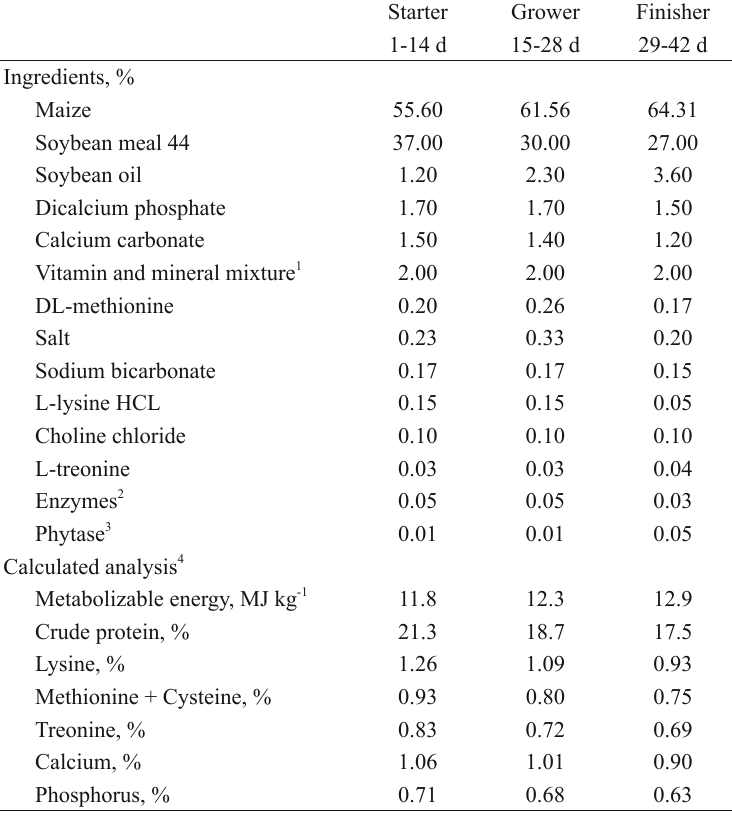
Experimental diets fed to broiler